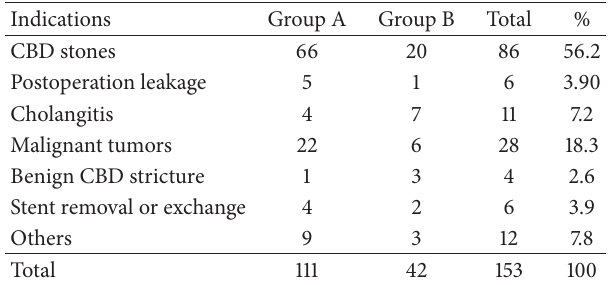
Figure 2: Patient ESD (mGy) compared with previous ERCP stu- dies. Table 1: ERCP clinical